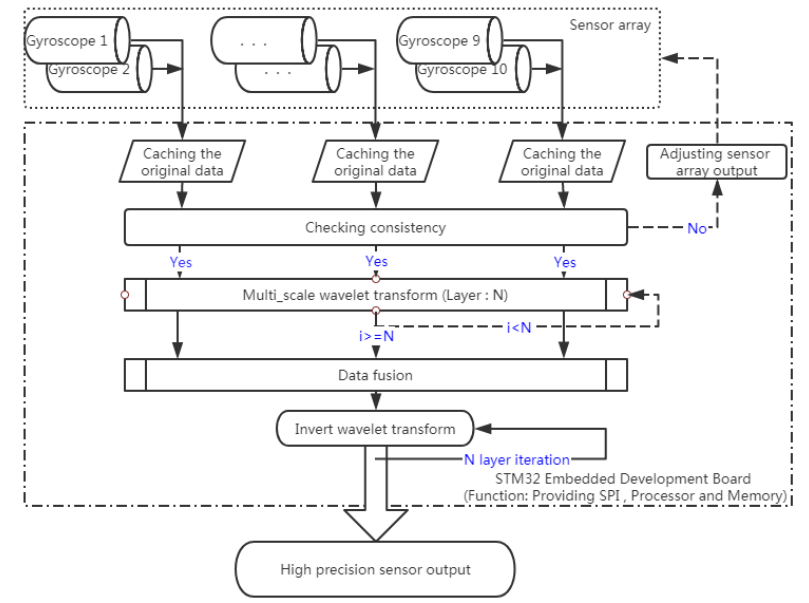
Figure 1. The flowchart of the WCF algorithm.